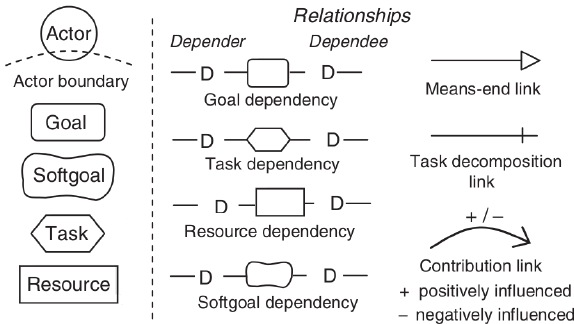
Figure 4. Notation of the i* modeling elements.